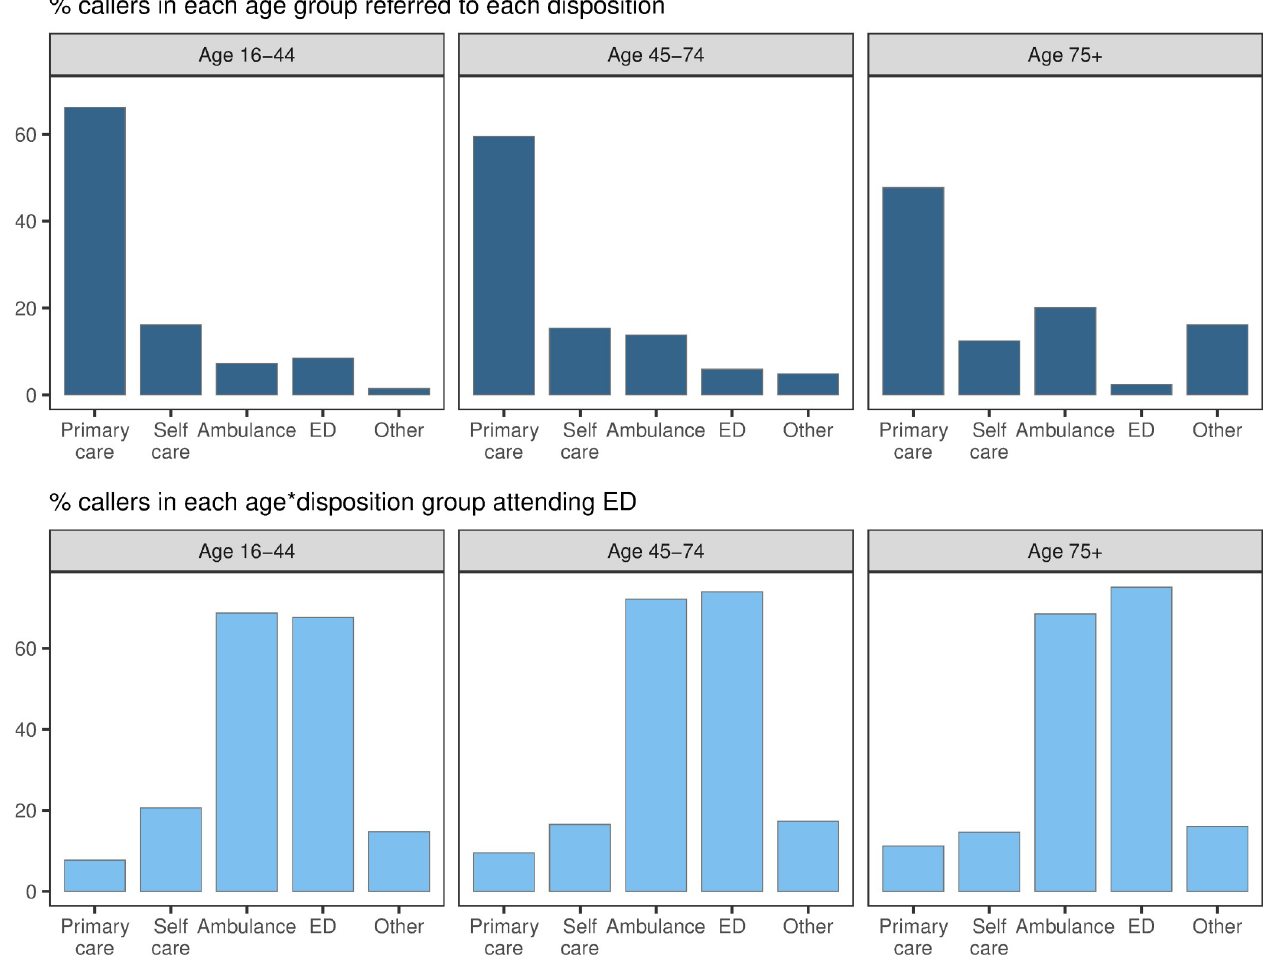
Fig 3. Proportion of NHS 111 callers given each disposition and attending ED, split by age. Top: percent of NHS 111 callers in each age group receiving each disposition; e.g., 66.2% of 16–44 year-olds were advised to contact primary care. Bottom: percent of NHS 111 callers in each age-disposition group who attended ED; e.g. 7.7% of 16–44 year-olds who were advised to contact primary care attended ED.